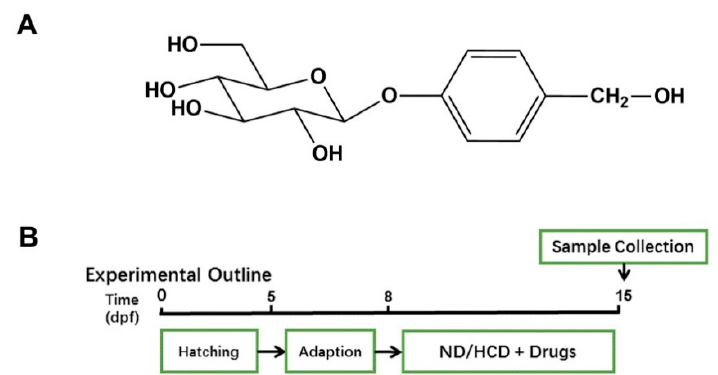
Figure 1. Effect of Gastrodin (GAS) on high cholesterol diet (HCD) induced larval zebrafish. ( A ) Chemical structure of GAS; ( B ) Experimental outline of the feeding protocol.